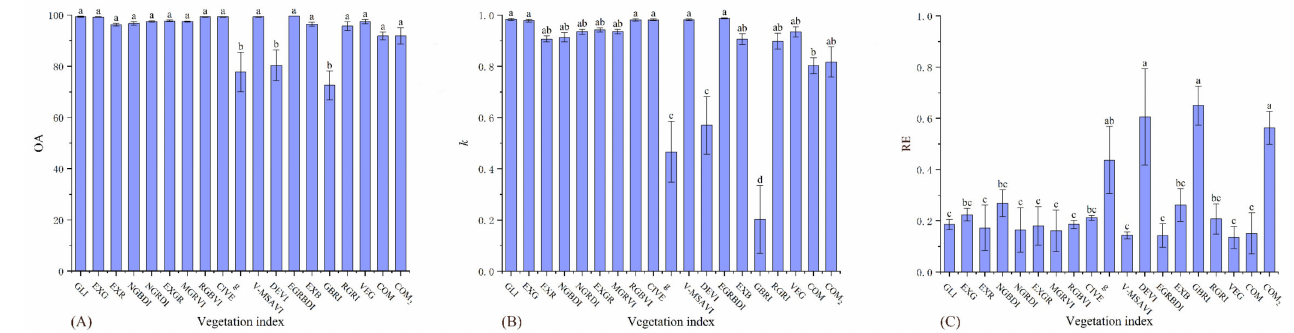
Figure 4. OA, k , and RE differences of 19 vegetation indices on the moderate desertification grade. ( A ) figure is the result of one-way analysis of variance for OA. ( B ) figure is the result of one-way analysis of variance for k . ( C ) figure is the result of one-way analysis of variance for RE. Values with the same lowercase letters within vegetation indices are not significantly different at p < 0.05.